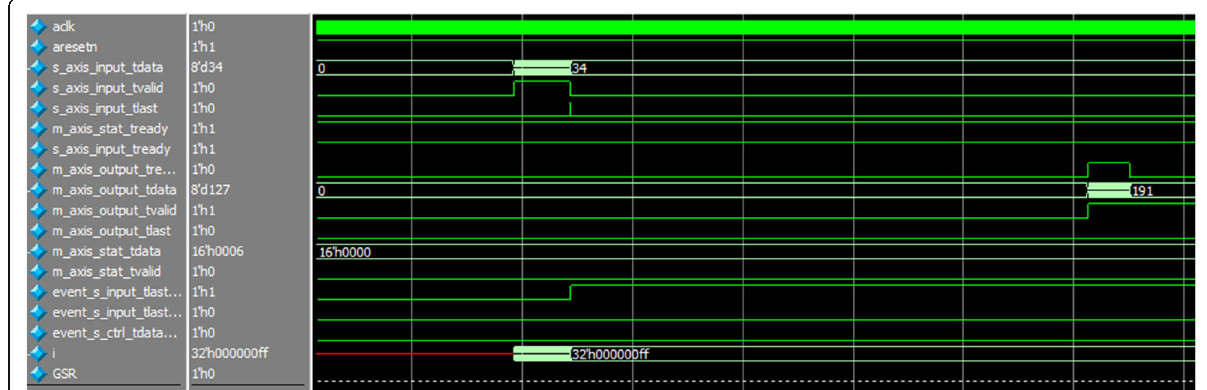
Fig. 11 The simulation diagram 1 of the RS decoder. The output data of the decoders. The decoding results are shown